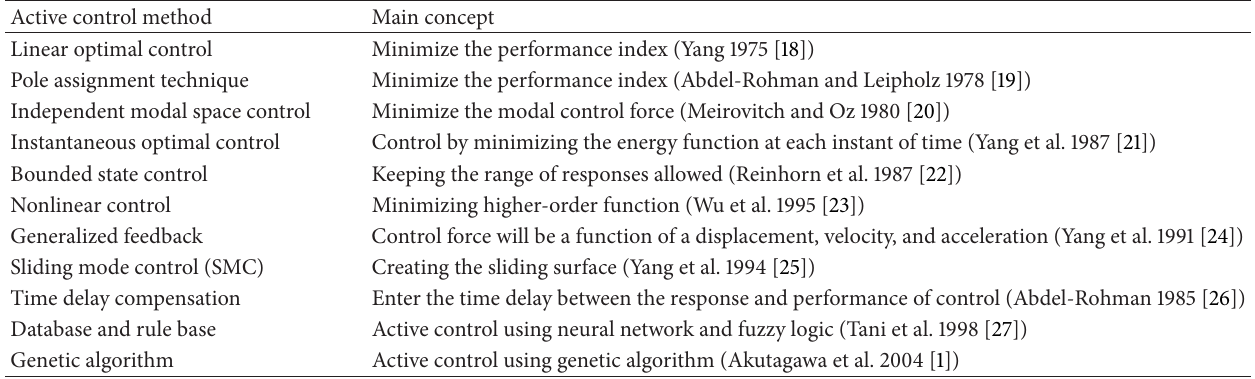
Table 1: Common Active Control